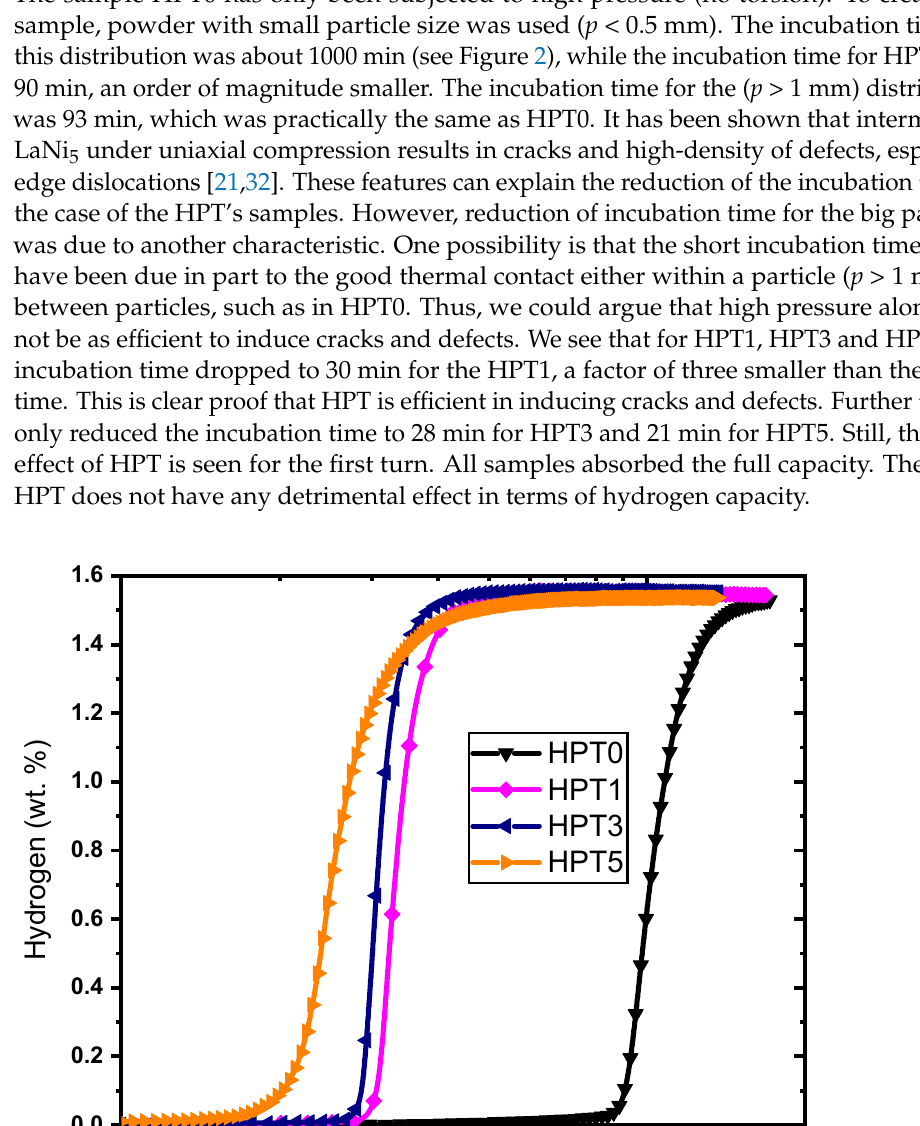
Figure 5. First dehydrogenation at room temperature under partial vacuum of HPT samples.